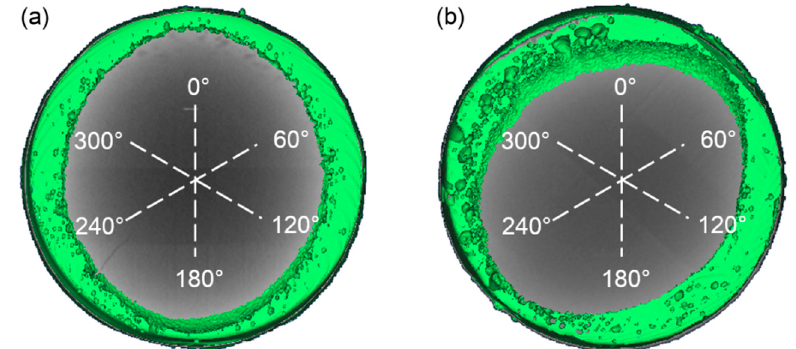
Figure 7. Computed Tomography (CT) test results of porosity defects in NS-Mo alloy joints produced under: ( a ) heat input 250 J/cm; ( b ) heat input 3600 J/cm.